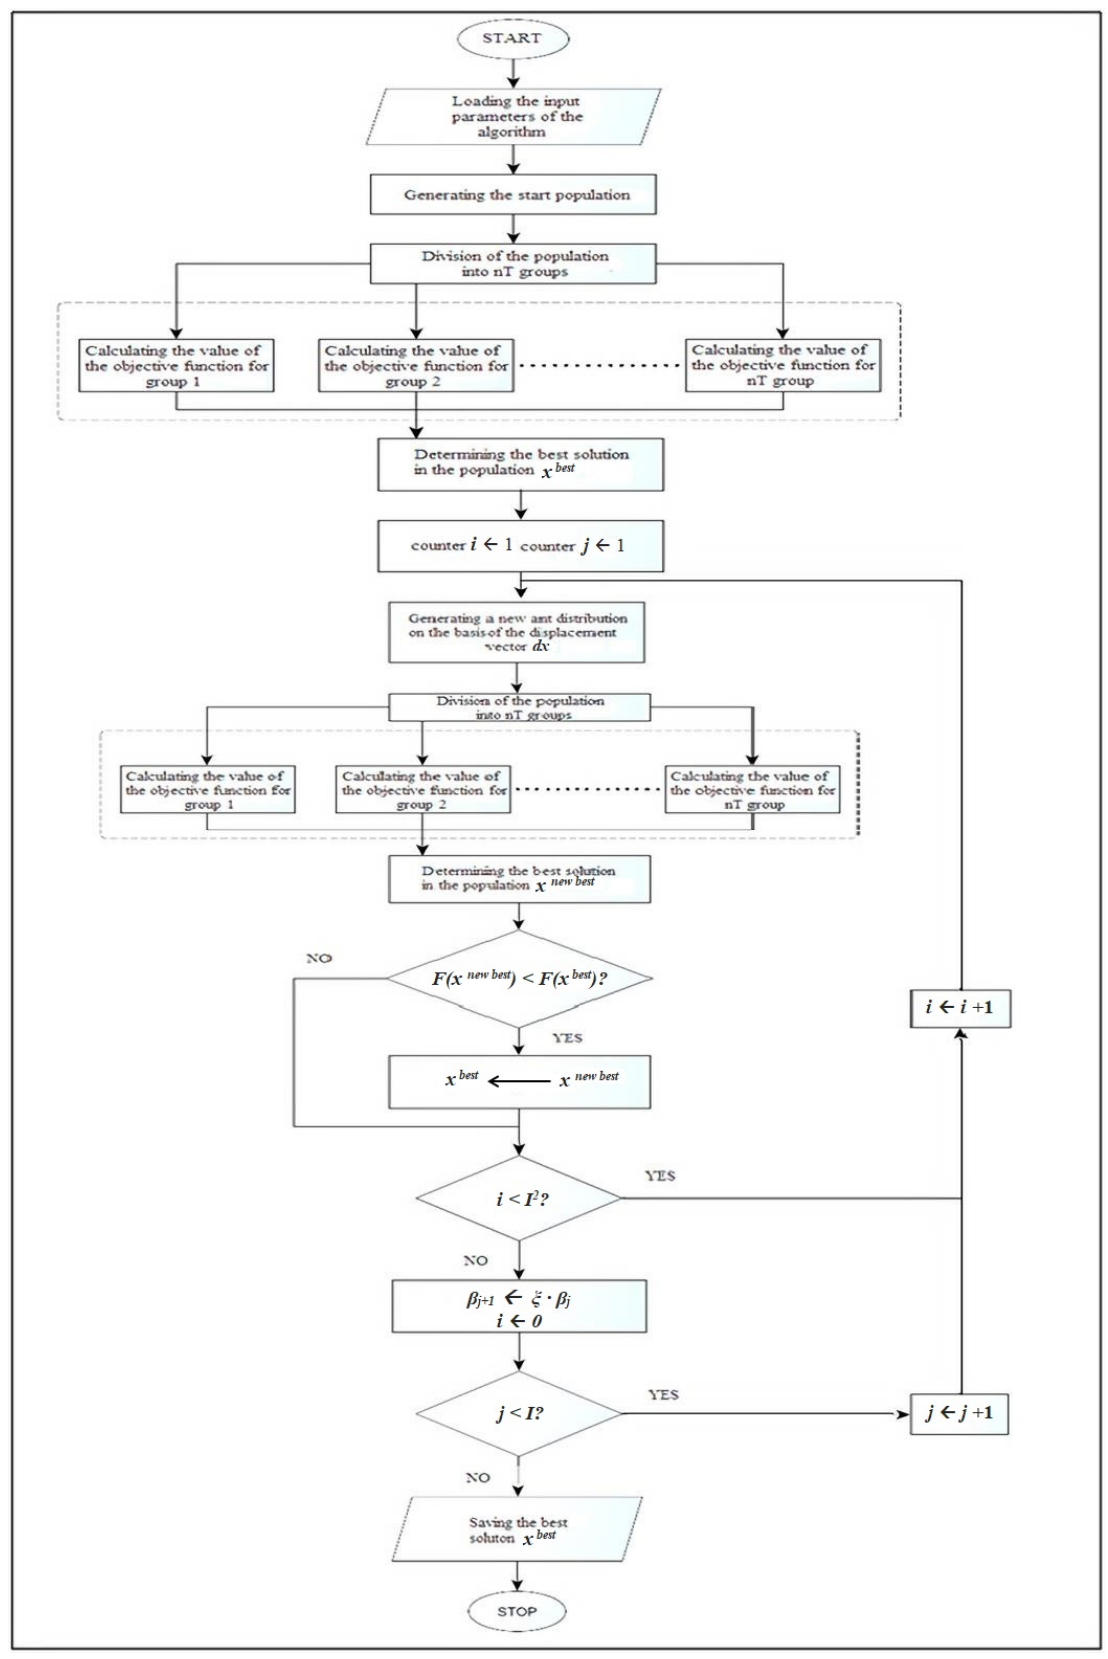
Figure 2. Scheme of the ant colony algorithm.